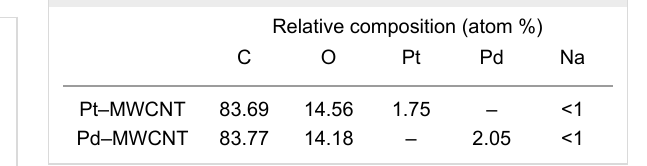
Table 1: Elemental chemical composition percentage as derived from an XPS analysis of the Pt-decorated and Pd-decorated carbon nanotube